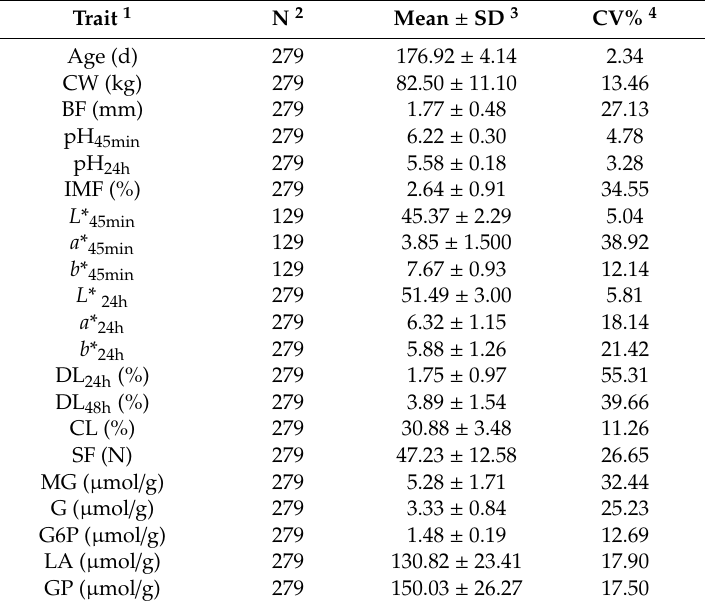
Table 2. Phenotype information for experimental pig